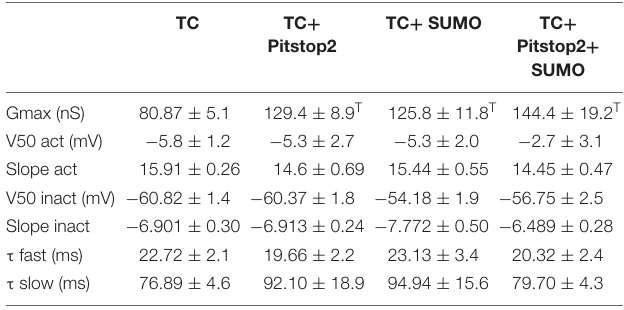
TABLE 2 | Whole-cell patch clamp data when clathrin-mediated endocytosis was blocked using